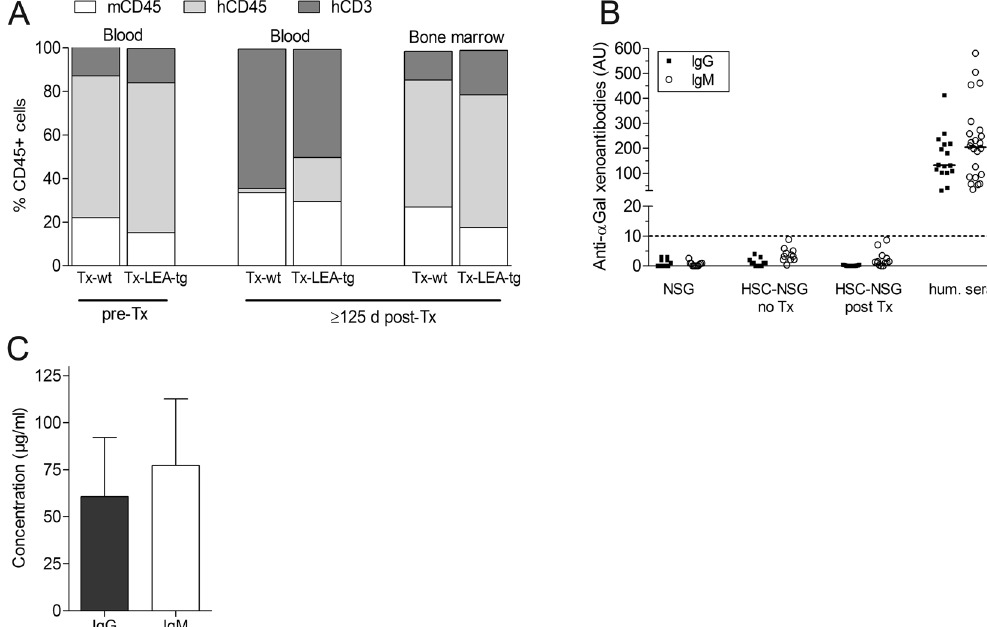
Figure 1. Reconstitution of human immune system and production of antibodies in NSG mice (HU-SRC- SCID) transplanted with wild-type (Tx-wt) or INS LEA29Y transgenic (Tx-LEA-tg) NPICCs. Isolated human CD34 + hematopoietic stem cells were transferred to NSG mice. After 16–20 weeks and at the end of the observation period the percentage of human immune cells (hCD45 + ) and immune cell subsets (gated on human CD45) were analyzed by FACS ( A ). Xenoantibodies ( B ) and plasma levels of human IgG and human IgM ( C ) were measured by